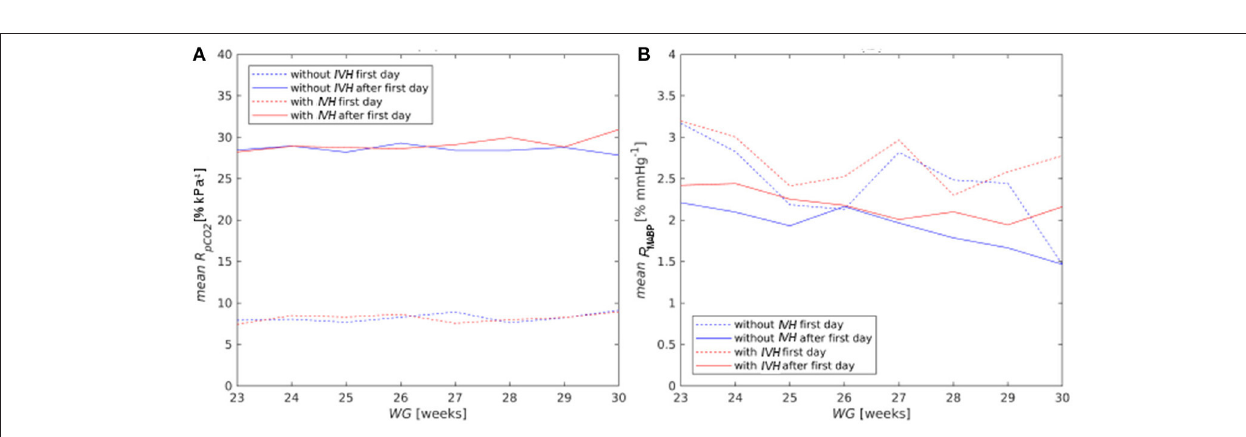
FIGURE 6 | Mean reactivity of CBF on pCO 2 (A) and MABP (B) for the first (dashed curves) and after the first day of life (solid